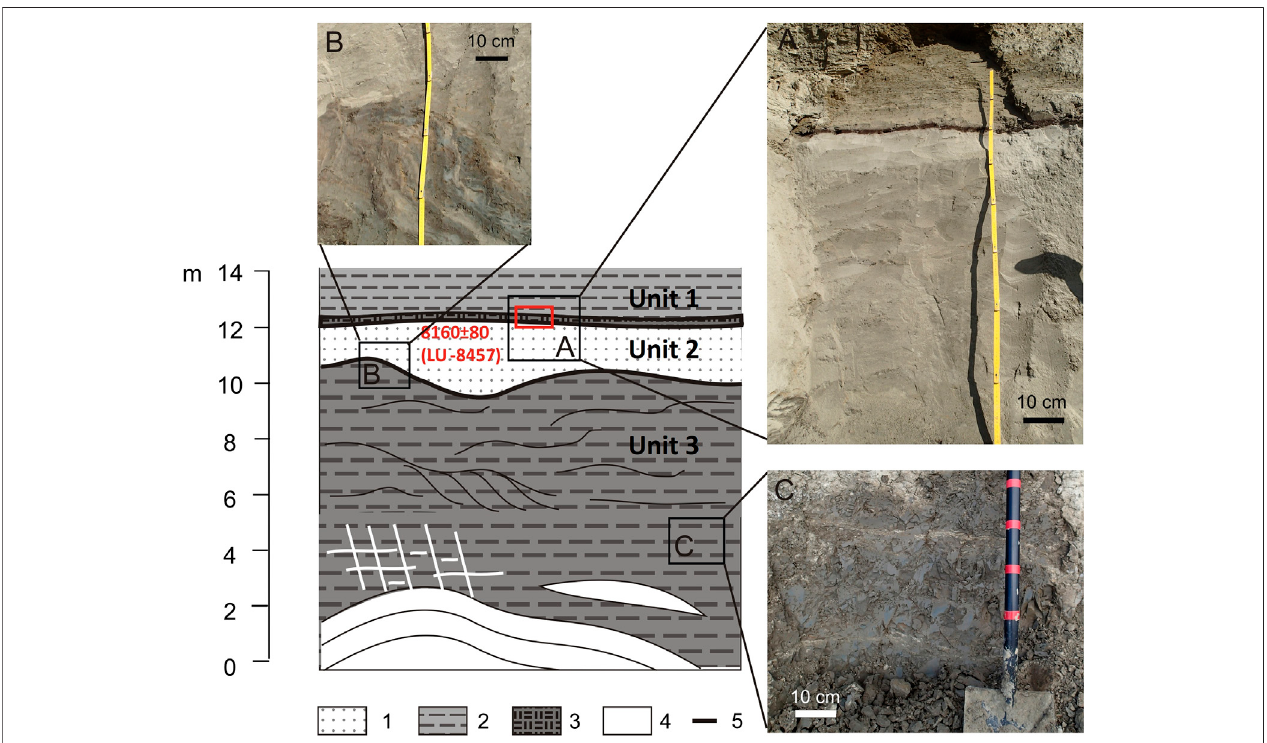
FIGURE 2 | General section of Quaternary sediments outcropping in the coastal bluffs of the Gulf of Kruzenstern. 1 — sands, 2 — silts, 3 — peat, 4 — ice, 5 — geologicalinterfaces. (A) Brownsiltsoftheupperlayer,underlainbypeat;poorlysortedthinsandsofthetopofthemiddlelayer. (B) Erosionalcontactbetweensands ofthemiddleunitand siltsand claysofthelowerunit; deformationsintheupper partofthelowerunit. (C) Darkgray siltsandclays ofthebottomunit. Theredbox shows the position of material taken for radiocarbon dating; the radiocarbon age, error and sample number are shown in red color.